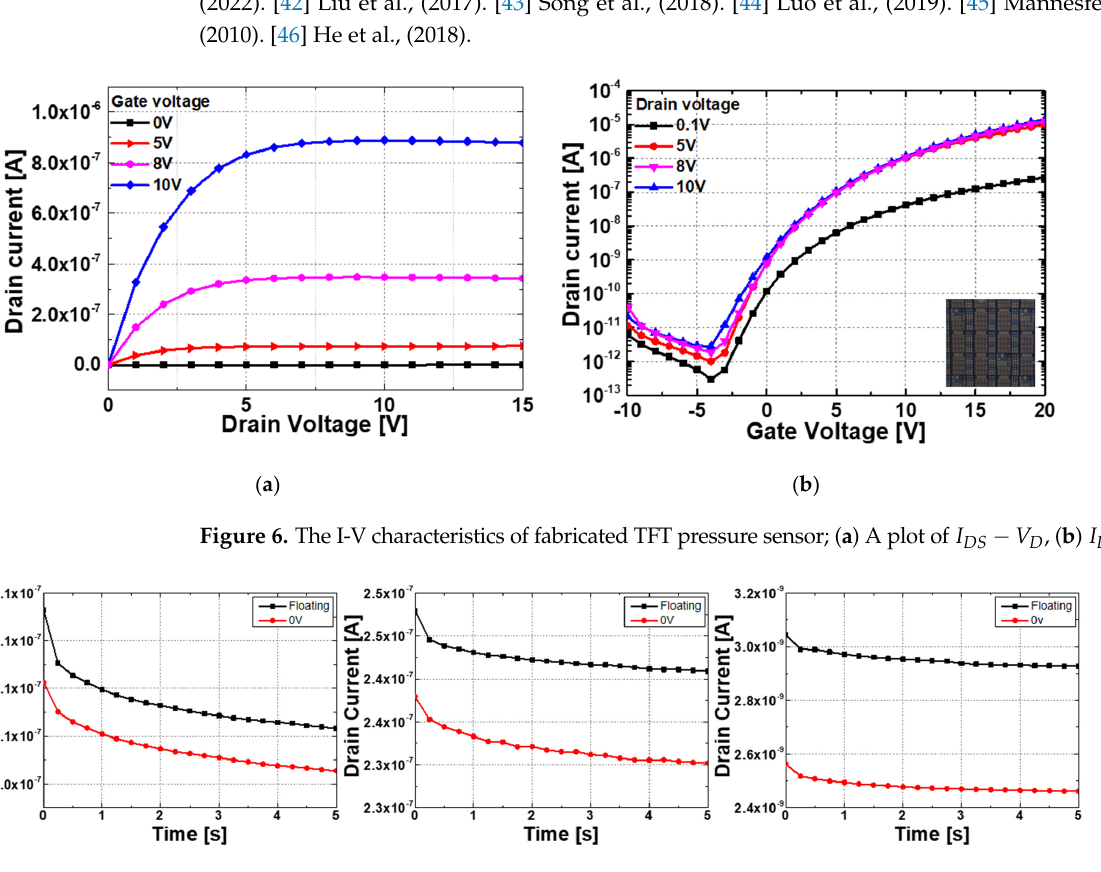
floating gate voltage, and the red line is 0 V biased to the gate; ( a ) Thin film type; ( b ) Film annealing